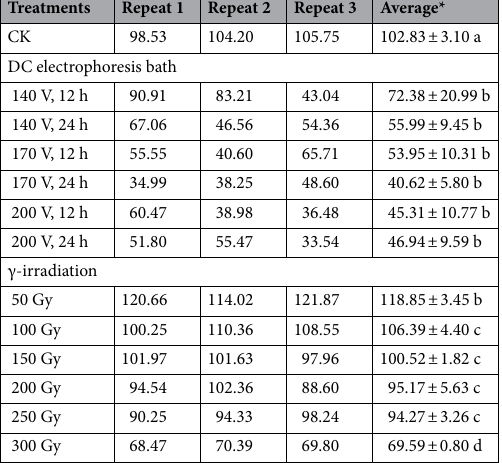
Table 2. Seed vigor index after treated with γ-irradiation and DC electrophoresis bath. *The different letters mean significant difference at 5% level.